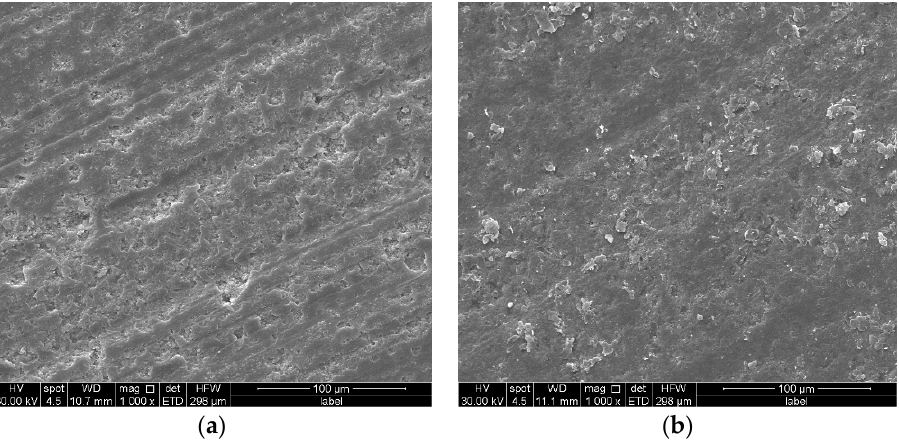
Figure 10. Worn surfaces of the SN10 pin against the PEEK disc in artificial seawater at the following different speeds: ( a ) 0.52 m/s; ( b ) 1.73 m/s.